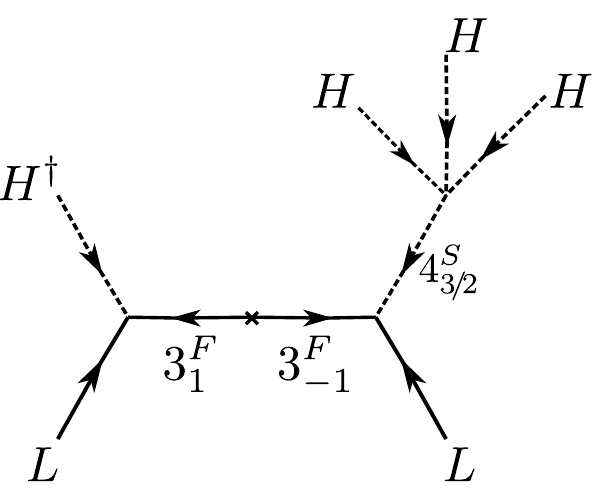
Figure 2 . The genuine tree-level diagram for d = 7 [25]. At least two beyond-the-SM particles are needed for higher dimensional